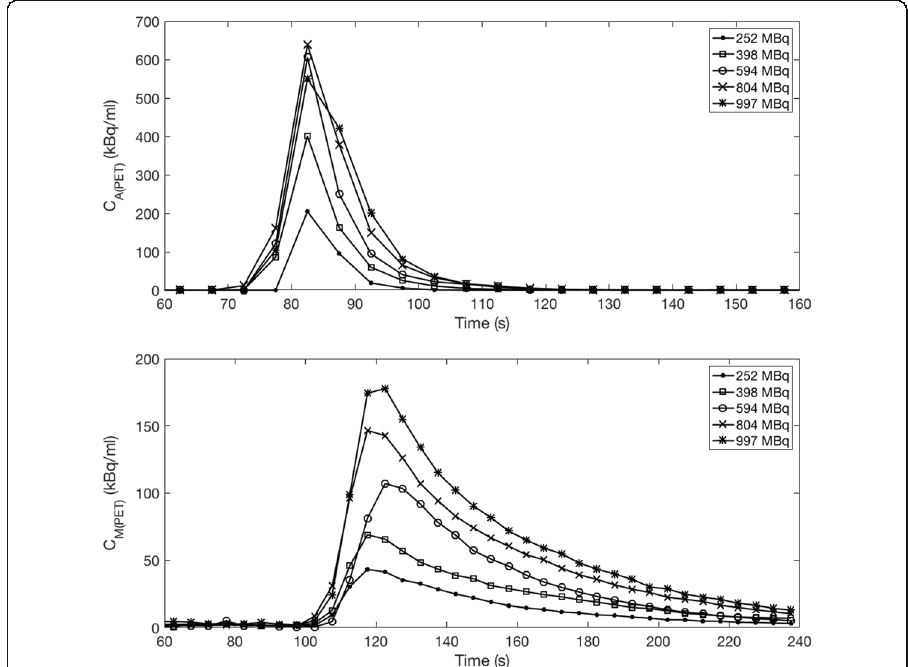
Fig. 5 Time-activity curves resulting from image analysis with increasing activity administrations to the phantom. Top: C A (PET) , and bottom: C M (PET) , showing input and washout of the radiotracer. C A (PET) for 804 and 997 MBq injected activities do not increase at the same rate as the myocardial TAC suggesting the reconstructed images are affected by count